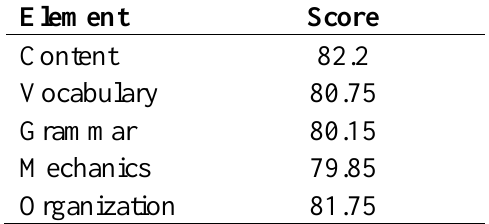
Table 2. The Students’ Score of Post Test 1 Viewed from Each